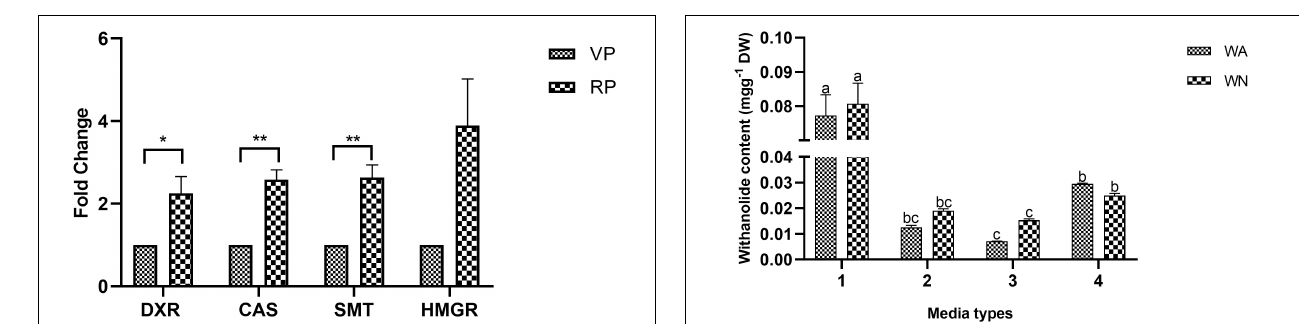
FIGURE 8 | Withanolide A and withanone content (mg g − 1 DW) from root cultures of Withania somnifera . (1) MS + 0.5 mg L − 1 IAA + 1.0 mg L − 1 IBA,